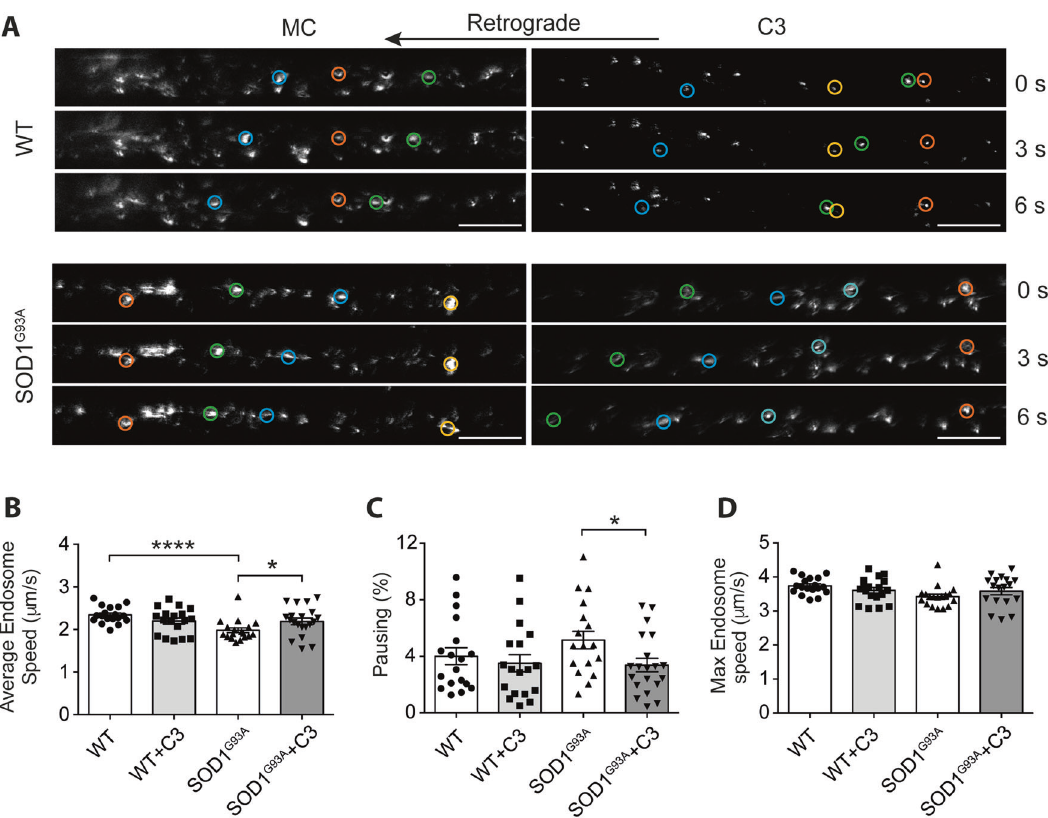
methyl cellulose). Coloured circles highlight frame-to-frame endosomal movements (orange/yellow represent paused endosomes, blue/green represent retrogradely transporting endosomes). Scale bars, 20 µm. B – D Average speeds ( B ), percentage pausing ( C ) and maximum transport speeds ( D ) of in vivo signalling endosome transport in the sciatic nerve of P73 SOD1 G93A mice following C3 treatment compared to vehicle control (MC; 1% methyl cellulose in PBS). C : **** p < 0.0001; * p = 0.0415; D : * p = 0.0284; Student ’ s t test. N = 6 animals. Statistics were carried out per axon (3 per mouse, 18 per condition). Bars represent mean ±